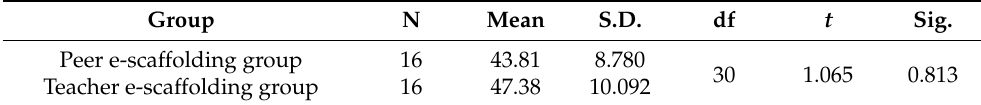
Table 5. Independent-samples t -test of the results of the technology fatigue survey. Group N Mean S.D. df t Sig. Peer e-scaffolding